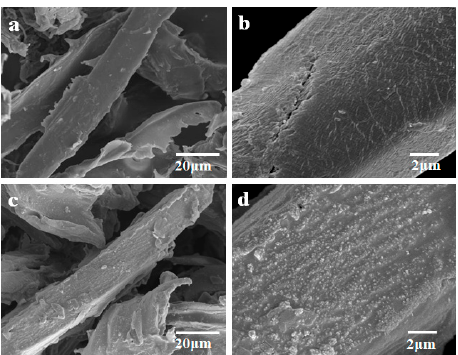
Figure 2. SEM images of pristine wood flour. ( a , b ) without nZnO aggregates and superhydrophobic/superoleophilic wood flour, and ( c , d ) with nZnO aggregates at low and high magnifications.